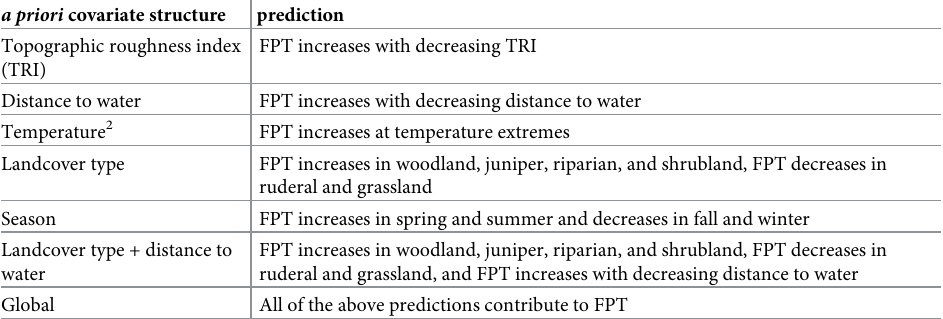
Table 2. A priori models of covariates hypothesized to influence first passage time (FPT) and their predicted effects on GPS collared wild pigs on Fort Hood Military Installation in 2016–2017. a priori covariate